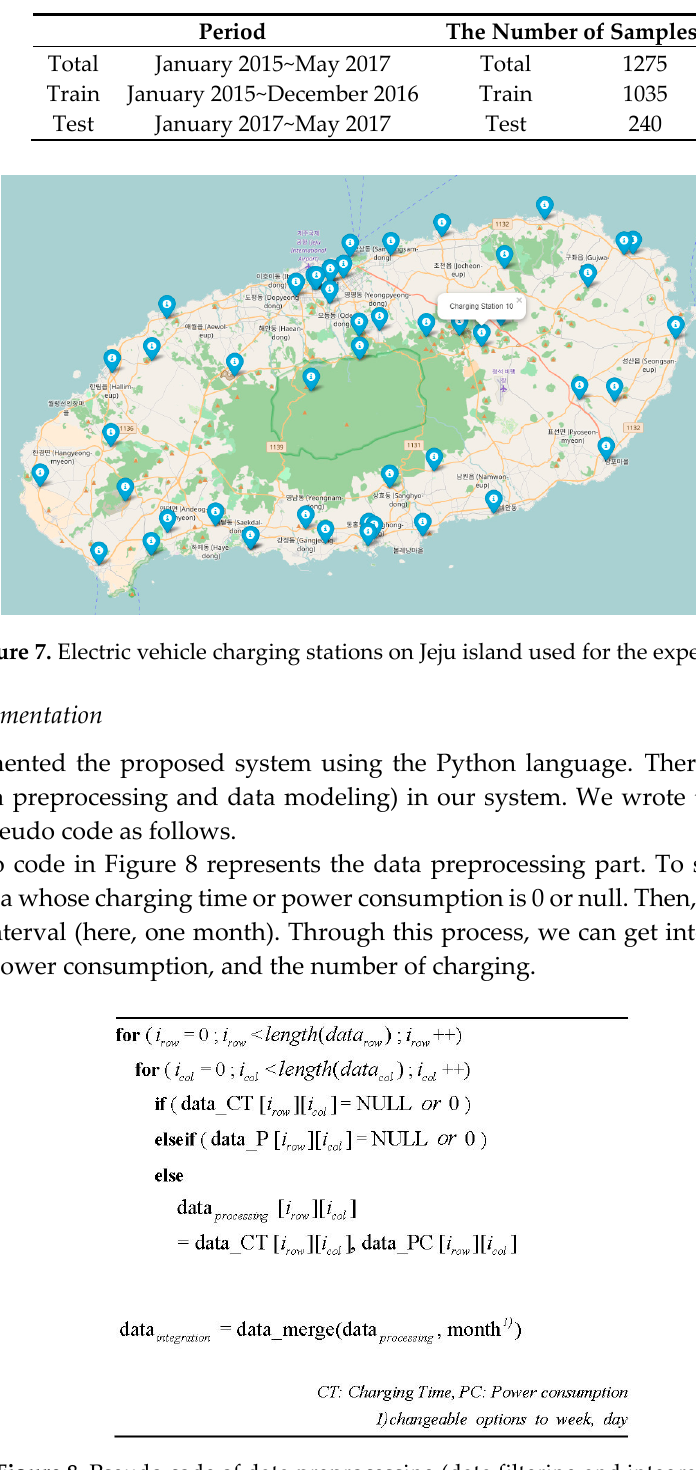
Figure 8. Pseudo code of data preprocessing (data filtering and